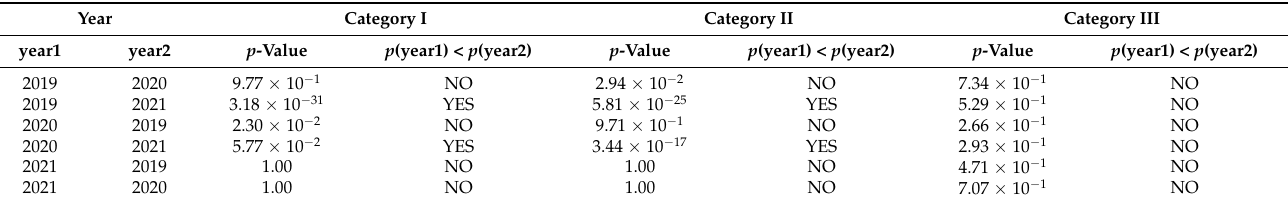
Table 1. Summary of proportion test—attempted suicides.